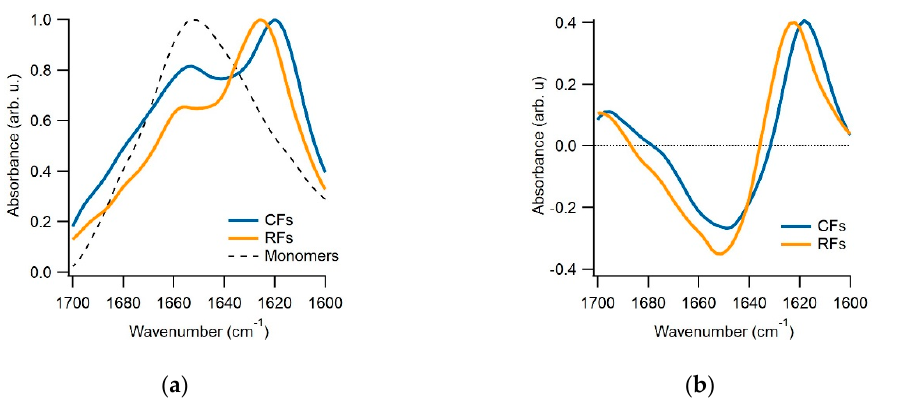
Figure 2. FTIR spectra of hewL monomers, curvilinear fibrils (CFs) and Rigid fibrils (RFs). ( a ) Peak-matched FTIR absorption spectra of the Amide-I band for hewL monomers and isolated CFs and RFs at pH 2. CFs and RFs show a prominent peak in the characteristic amyloid band between 1630 and 1610 cm − 1 . Yet their peak wavenumbers are slightly but reproducibly shifted with respect to each other. ( b ) The CF and RF differences spectra obtained after subtraction of the monomer spectrum in ( a ).